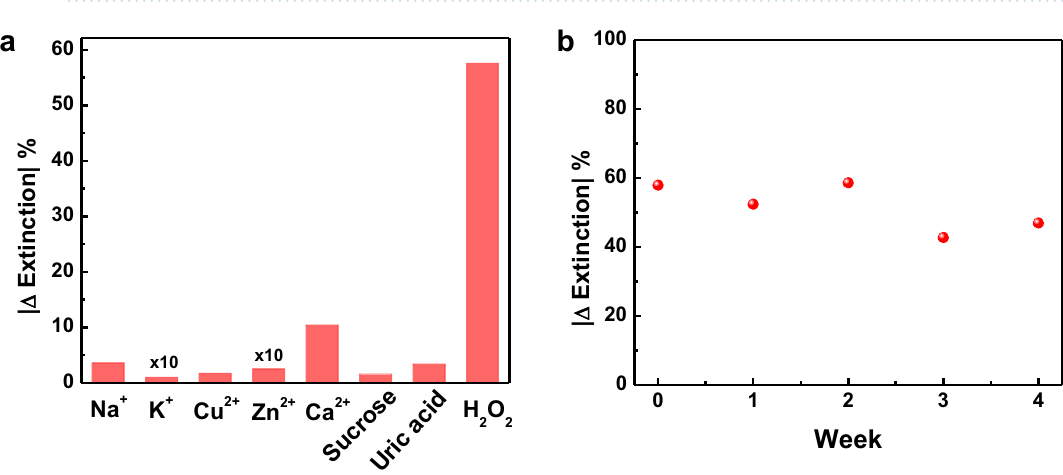
Figure 5. ( a ) Selectivity of the Au@Ag nanocubes sensor toward H 2 O 2 . ( b ) Stability of the Au@Ag nanocubes sensor toward H 2 O 2 (200